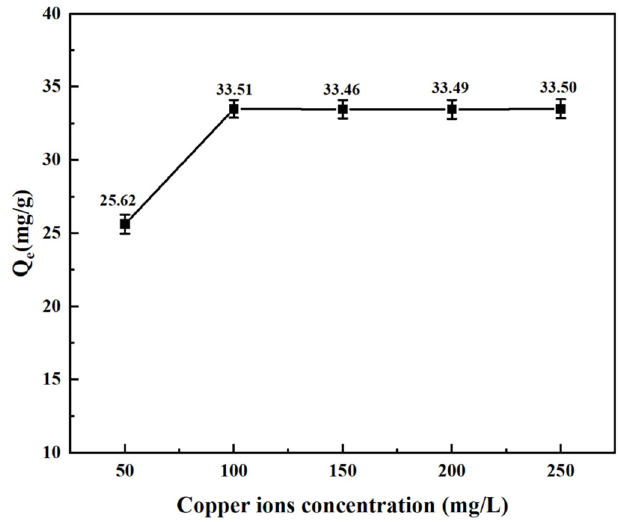
Figure 12. Effects of copper ion concentration on the adsorption of Cu 2+ onto SA-Ch.